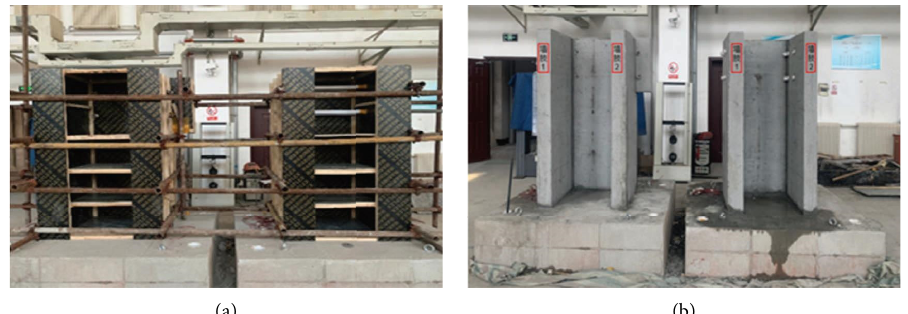
Figure 10: Fabrication and formation of walls. (a) Formwork support. (b) Specimen